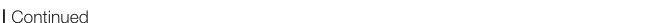
FIGURE 3 | Continued dot-fields. In most cases hummingbirds docked multiple times within a single stimulus trial (multiple feeds within a trial) and this is indicated by the increasing diameter of the raw data symbols. Summary statistics of all feeds in a stimulus and pattern group are shown by box-and-whisker plots. Hummingbirds push against the feeder to stabilize right and left dot-field motion, and only significantly push to the right for grating motion. There is no consistent horizontal push for vertical motions. (B) Horizontal push was measured for docked hummingbirds feeding in front of gratings and dot-fields moving to the bird’s left at different speeds from 0 to 120 ◦ /s. Raw data are shown along with summary box-and-whisker plots. Although responses to the two patterns are not statistically different, pattern means are illustrated by colored lines to visualize the tuning curve. The individual tuning curves for each of the eight individual birds are shown in gray (combined responses for the two patterns). Overall, birds exhibit a response plateau by 12 ◦ /s that then declines for motion faster than 84 ◦ /s. No response was measured for patterns moving at 2 ◦